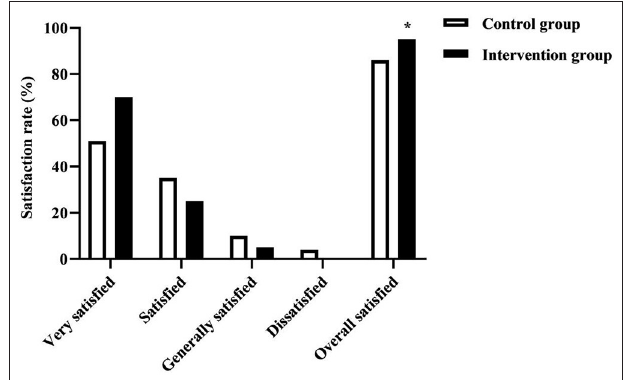
FIGURE 5 | The treatment satisfaction rate in the two groups of patients. * was the comparison of similar items between groups, P < 0.05. The intervention group was no